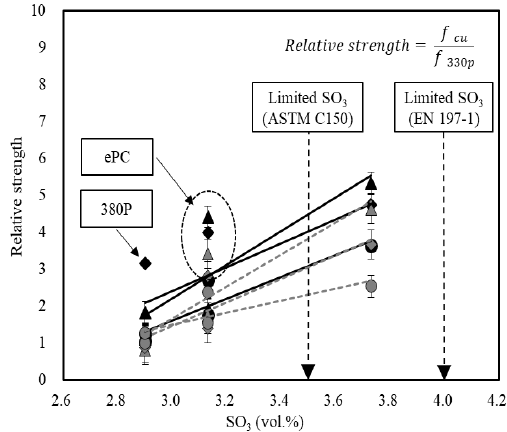
Figure 11. Relation between SO 3 contents of cement and compressive strength development.